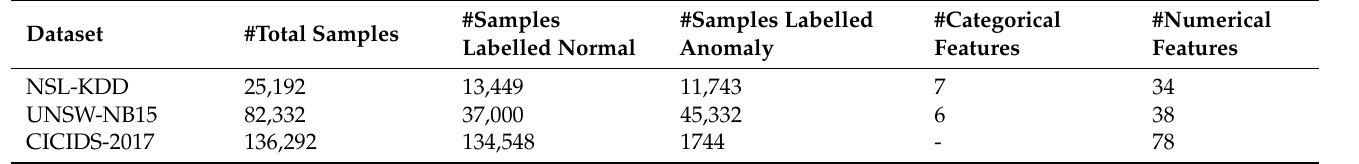
Table 2. Description of training data